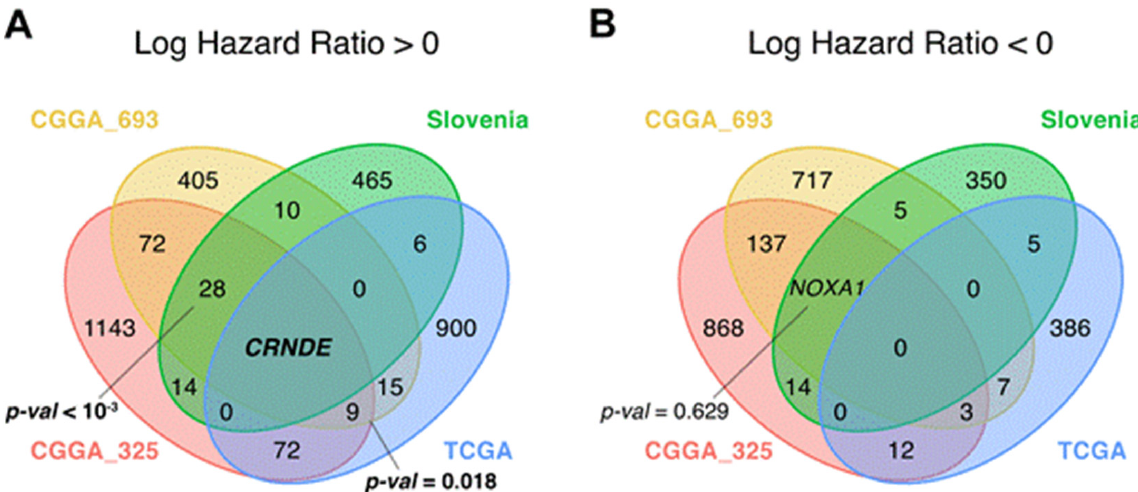
Figure 4. Intersections of differential ( A ) plus (hazard ratio > 0) and ( B ) minus (hazard ratio < 0) genes for overall survival (OS) analysis between CGGA_325, CGGA_693, TCGA and the experimental (Slovenia) glioblastoma samples; p -values for intersection significance that are less than 0.05 are highlighted in bold.